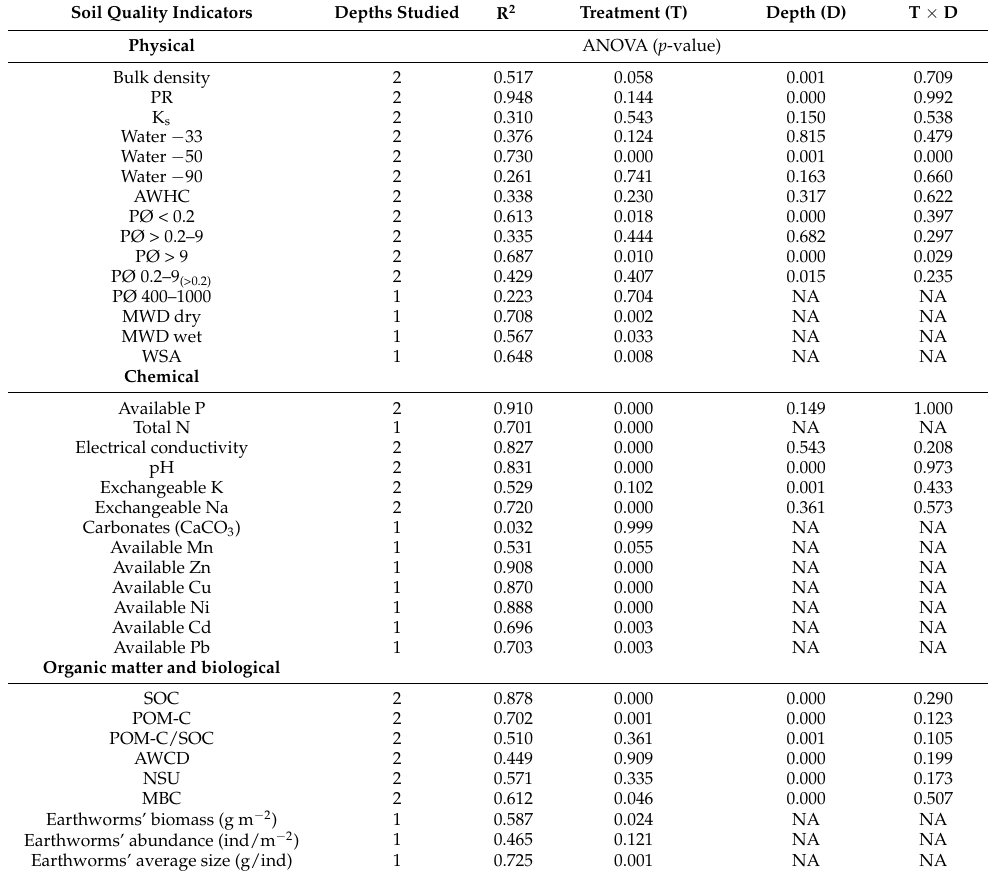
Table 3. Results of the analysis of variance (ANOVA) for all soil properties.